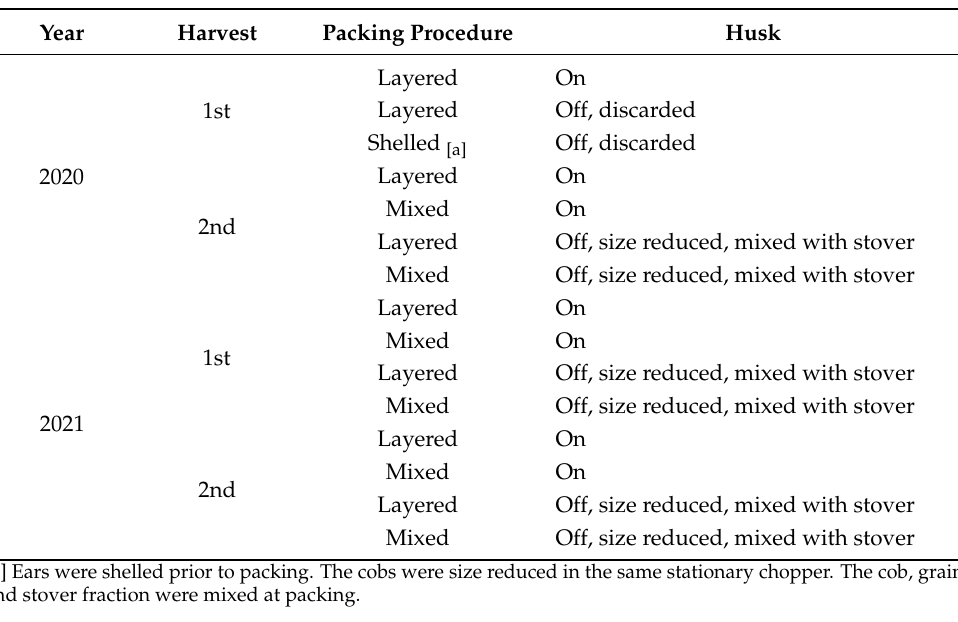
Table 1. Independent variables evaluated for this study.